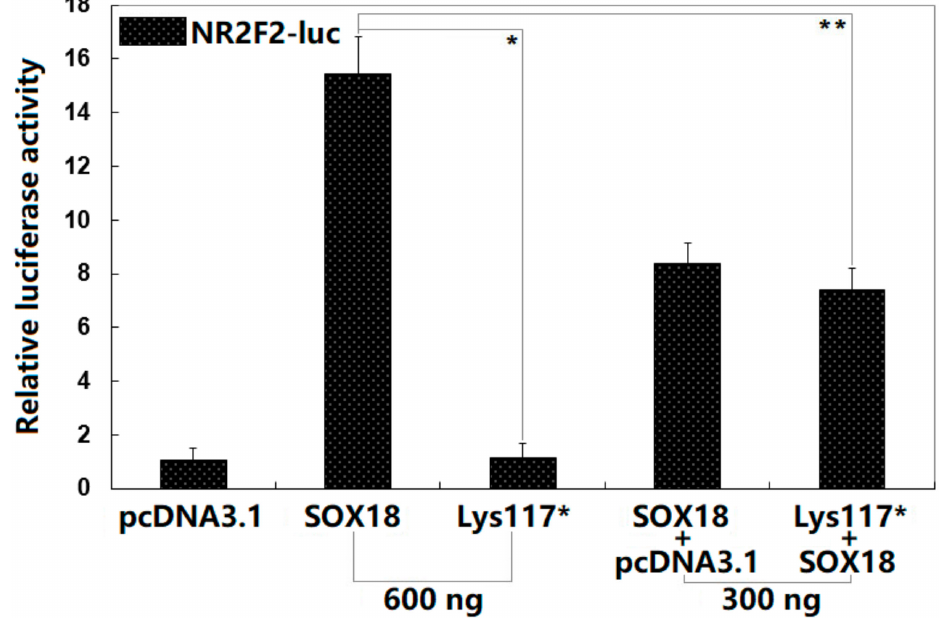
Figure 4. Functional impairment of SOX18 resulted from the variation. Reporter gene assay of the activation of the NR2F2 promoter-driven luciferase in cultivated HeLa cells by wild-type SOX18 or Lys117*-mutant SOX18 (Lys117*), singly or together, revealed that the Lys117* variant had no transcription activity. For each recombinant expression plasmid, three independent experiments in vitro were fulfilled in triplicate. The Student’s t -test was employed to make the comparison between the two groups. Herein, * and ** denote p < 0.0001 and p < 0.001, respectively, in comparison with wild-type SOX18 (600